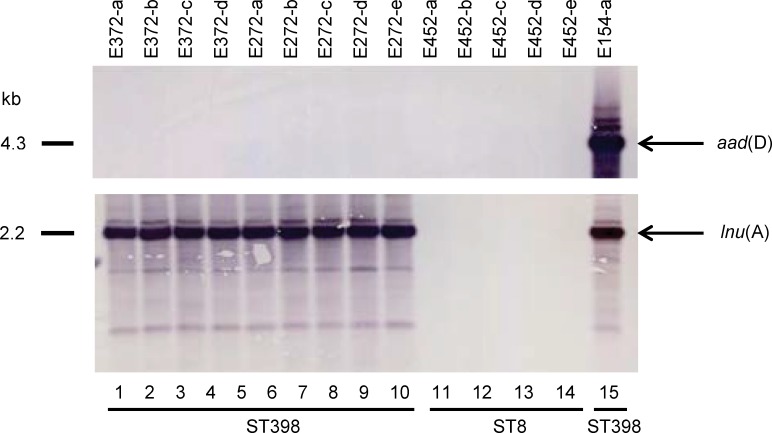
Plasmid location of aad(D) and lnu(A).Southernblot hybridization of plasmid DNA with DIG labelled probes for aad(D) top panel and lnu(A) bottom panel. Kb represents kilobase pairs.